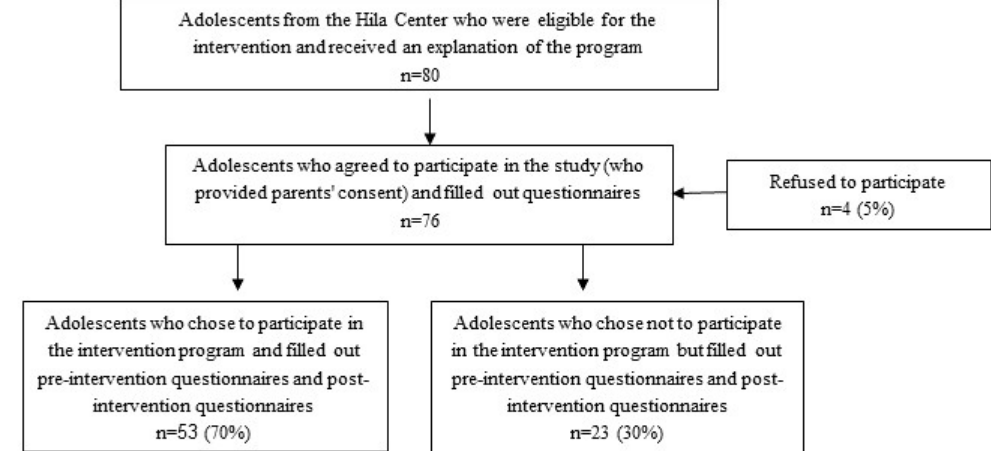
Figure 1. Flow of the study